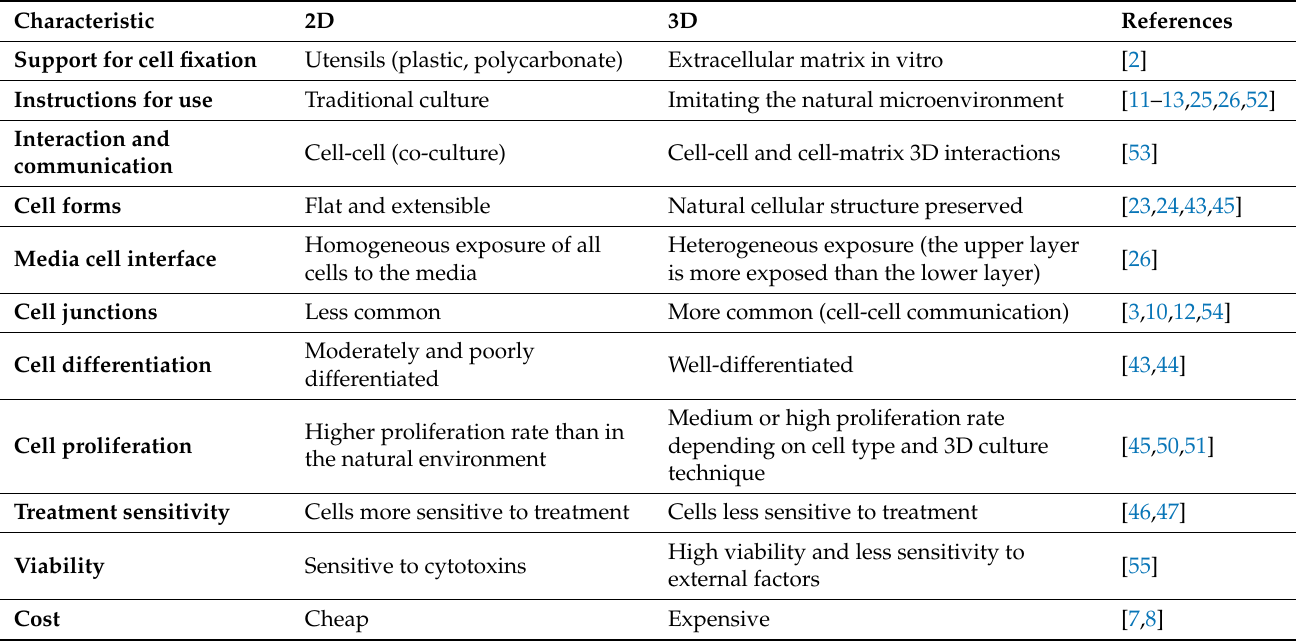
Table 1. Comparison between 2D and 3D culture